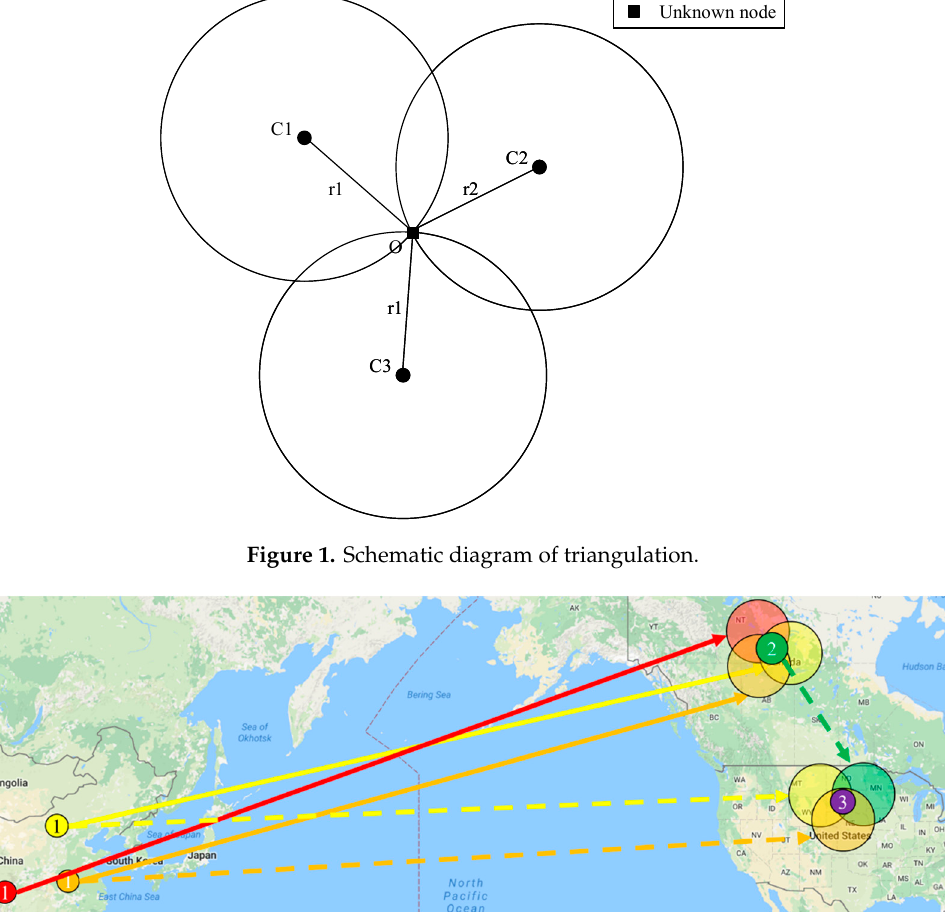
Figure 2. Schematic diagram of the Iterative Trilateration-based Localization Algorithm. (Modified from [7]).